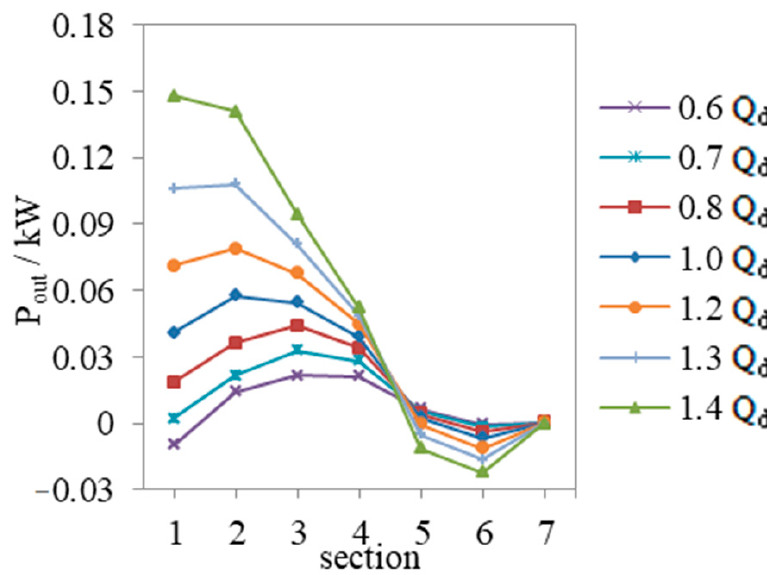
Figure 10. Output power of the runner in each section.